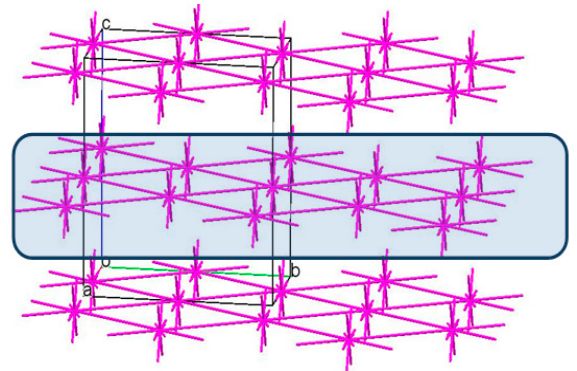
Figure 8. The packing of the dimers 2O_1 in the orthorhombic polymorphic form presented as the packing of energy-vector diagrams. The layer as the primary basis structural motif is highlighted in blue.